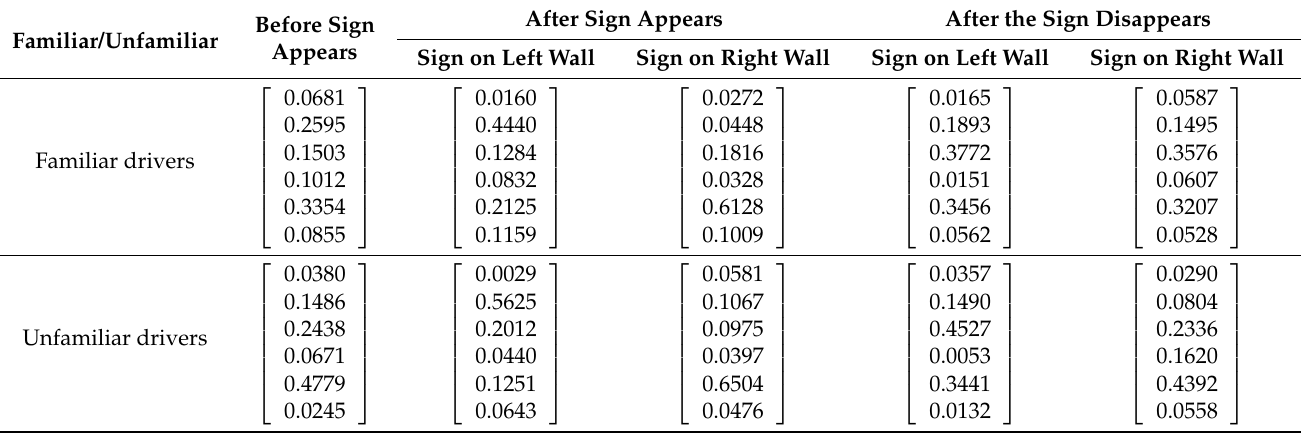
Table 4. Stationary distribution of the Markov chains in a